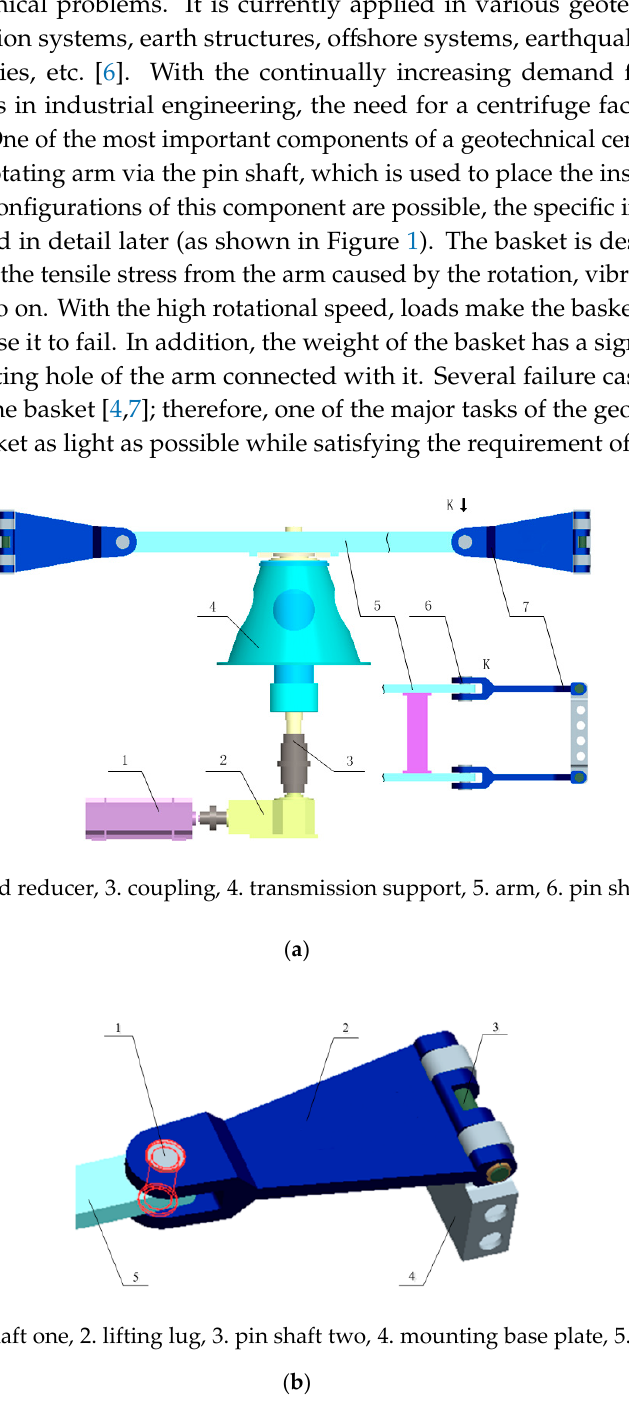
Figure 1. The structures of a geotechnical centrifuge and the basket. ( a ) The main structures of a geotechnical centrifuge. ( b ) The structures of the basket.